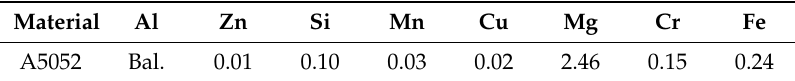
Table 2. Chemical composition of A5052 aluminum alloys (wt %).